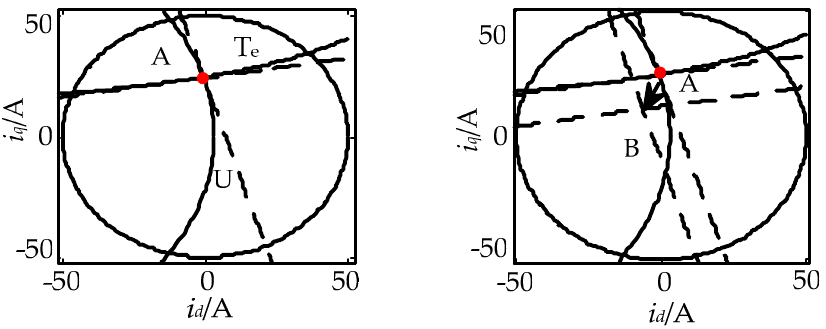
Figure 6. Linearized torque and voltage locus in the dq- axis framework.